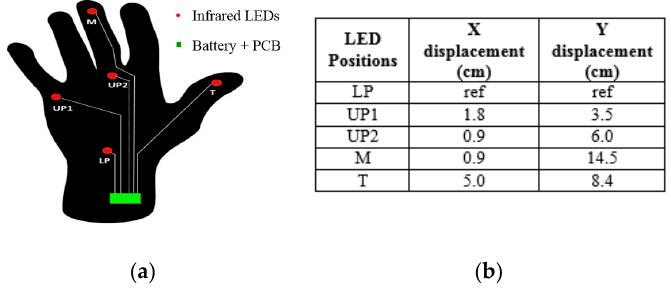
Figure 4. ( a ) Placement of LEDs in hand; ( b ) X and Y displacement of LEDs.